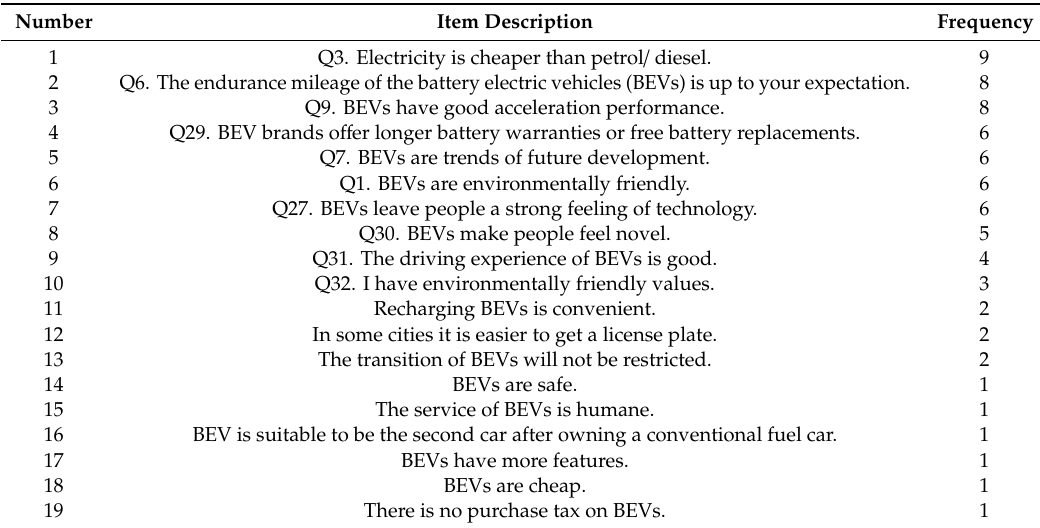
Table 5. Items derived from semi-structured review.